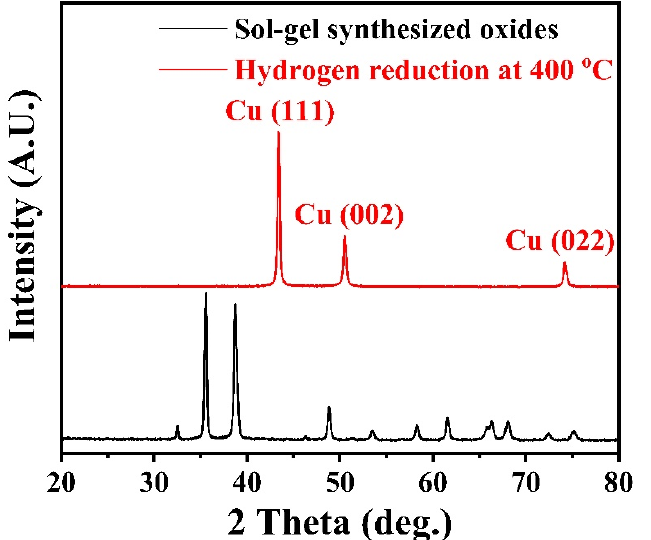
Figure 1. XRD patterns of sol-gel synthesized oxides and the powders hydrogen-reduction at 400 °C for 1 h.